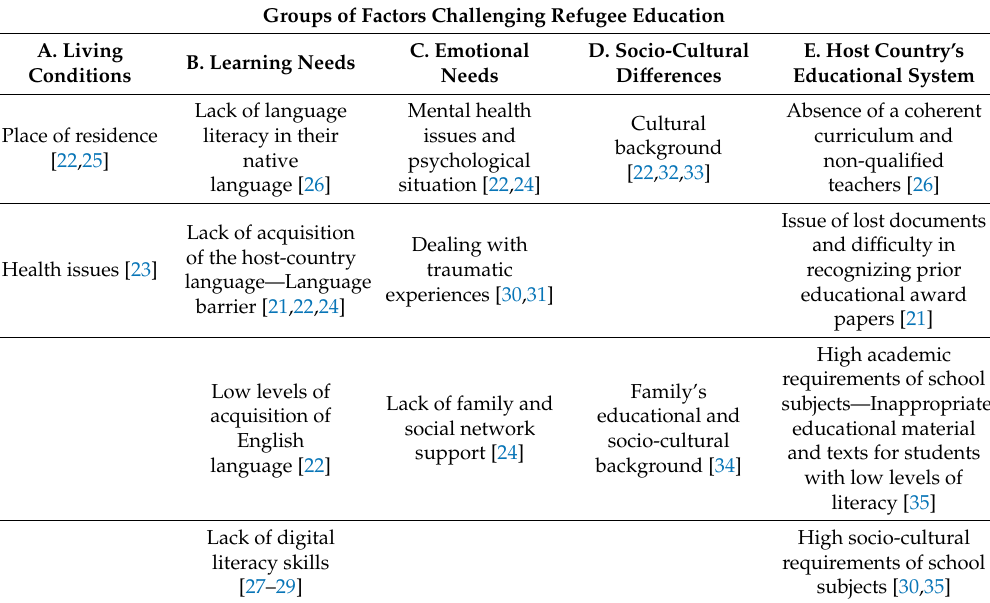
Table 1. Selected factors influencing refugee learning.